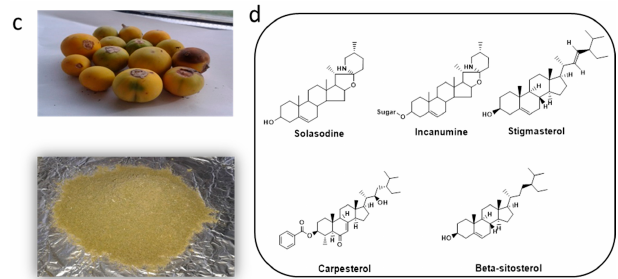
Figure 1. ( a ) Map of Yemen Republic indicating the area for the collection of the Jericho tomato; ( b ) This particular tomato represents a widespread agricultural weed rich in many biologically active substances. Although it is readily available across large regions of the Middle East and sub-Saharan Africa, it cannot be processed adequately in those countries and hence is of no particular use so far; ( c ) Dried fruits of S. incanum can be ground easily to form a green, powder-like material which in itself cannot be applied in practice. It can be processed further, for instance by extraction with organic solvents or via nanosizing; ( d ) Some of the main phytochemicals found in S. incanum which are considered to be responsible for its activity.